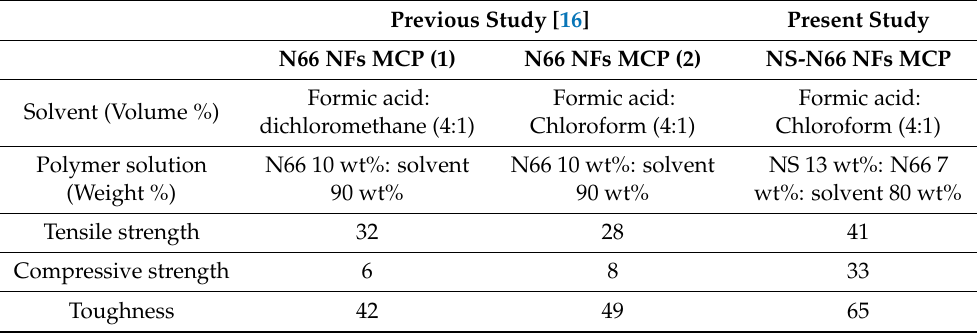
Table 2. Comparison of the mechanical strength results with [16] (the increase in